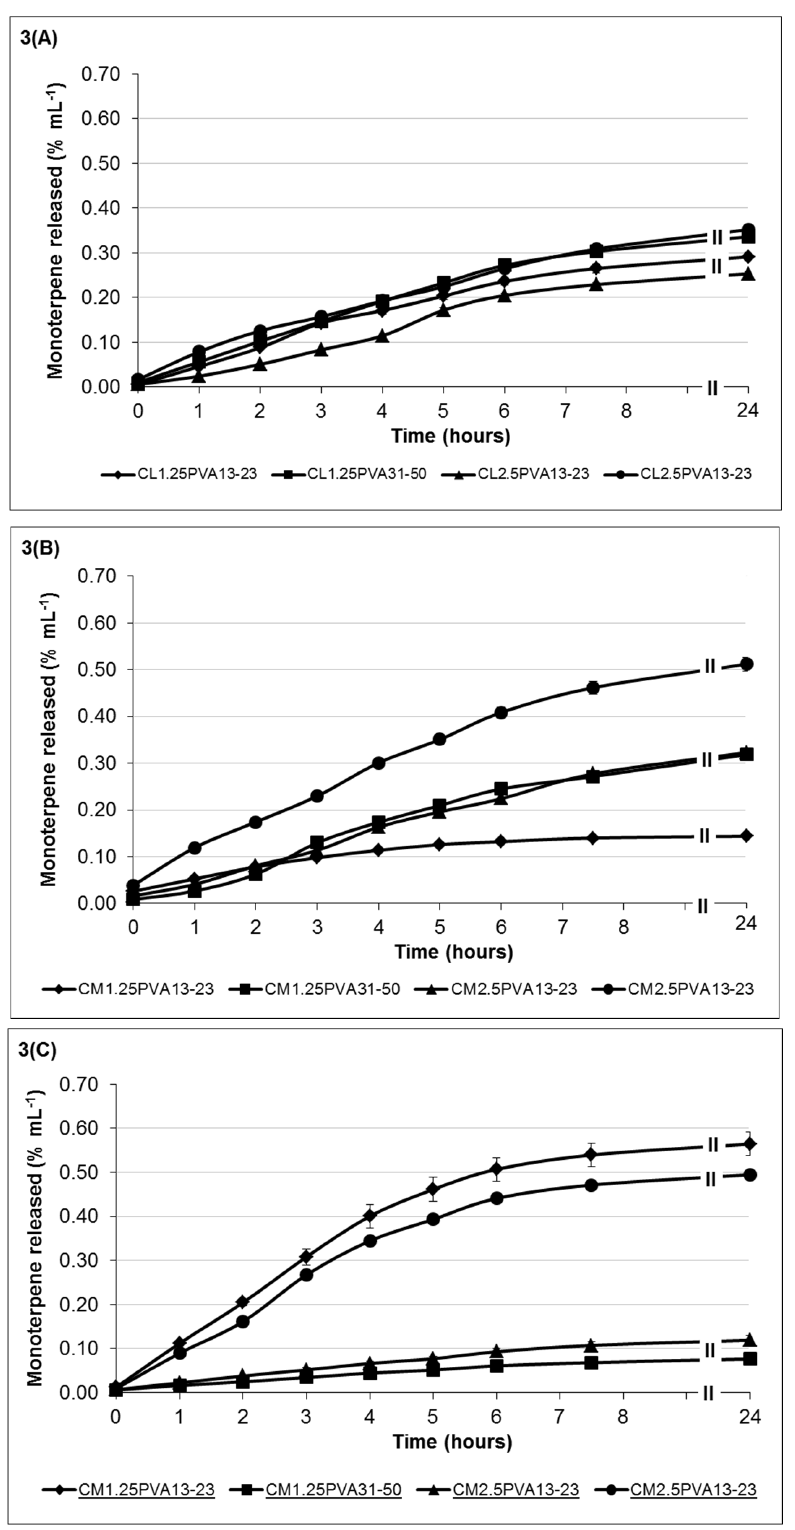
C M2.5 = 2.5% w / v medium ‐ viscosity chitosan, PVA 13 ‐ 23 = PVA 13–23 kDa, PVA 31 ‐ 50 = PVA 31–50 kDa. The error bars represents the standard deviation and n = 3.